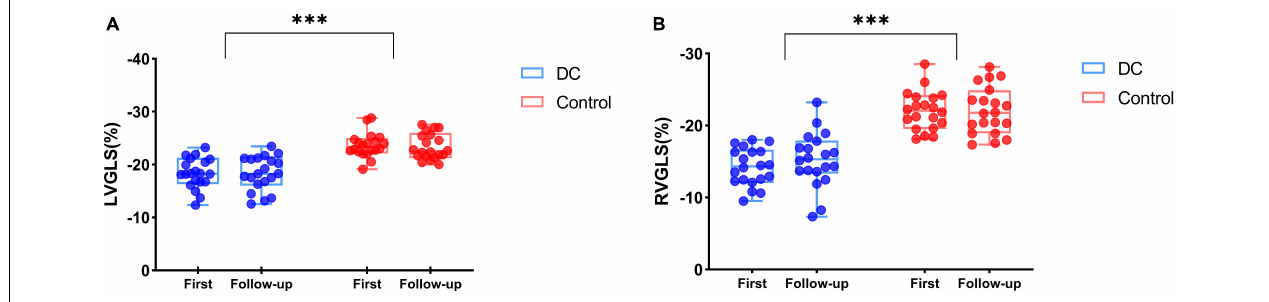
FIGURE 6 | The biventricular function of DC fetuses for follow-up examinations (Blue box and plots represent the GLS in the DC group, red box and plots represent GLS in the control group). Both LVGLS (A) and RVGLS (B) decreased in the DC group compared with the control group, but no difference was observed at follow-up in DC fetuses. *** p < 0.001, compared in DC group and control group. GLS, global longitudinal strain; DC, ductal constriction.